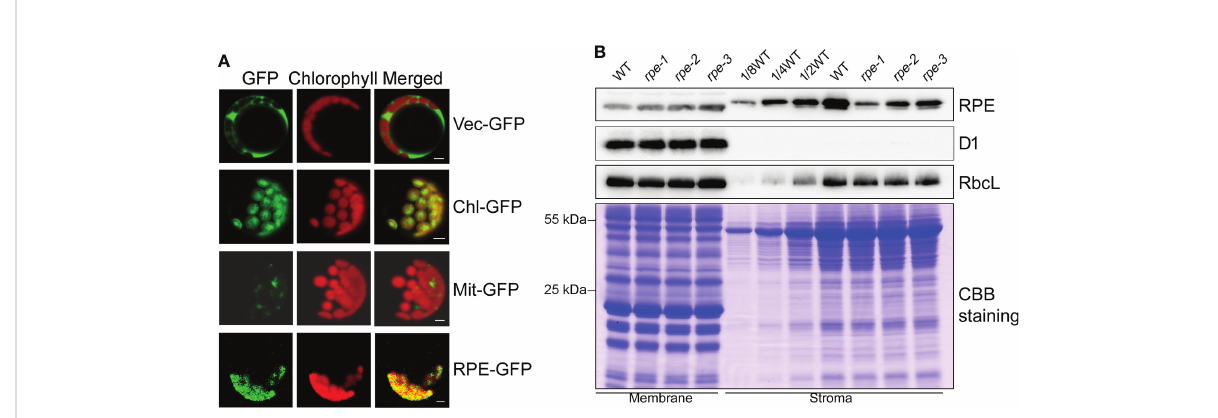
FIGURE 2 Subcellular localization of RPE. (A) Subcellular localization of RPE by GFP assay. RPE-GFP, RPE-GFP fusion; Vec-GFP, empty plasmid control; Chl-GFP, chloroplast control; Mit-GFP, mitochondrial control. Bars=5 m m. (B) Immunolocalization analysis of RPE. Intact chloroplasts isolated from WT and the rpe mutants were fractionated into membrane and stromal fractions, and immunoblot analyses were performed. D1 and RbcL were used as loading and fractionation controls. Thylakoids membrane protein containing equal amounts of chlorophyll and equal amounts of chloroplast stromal proteins were loaded on the gels. The gels were also stained with CBB for visualization of the